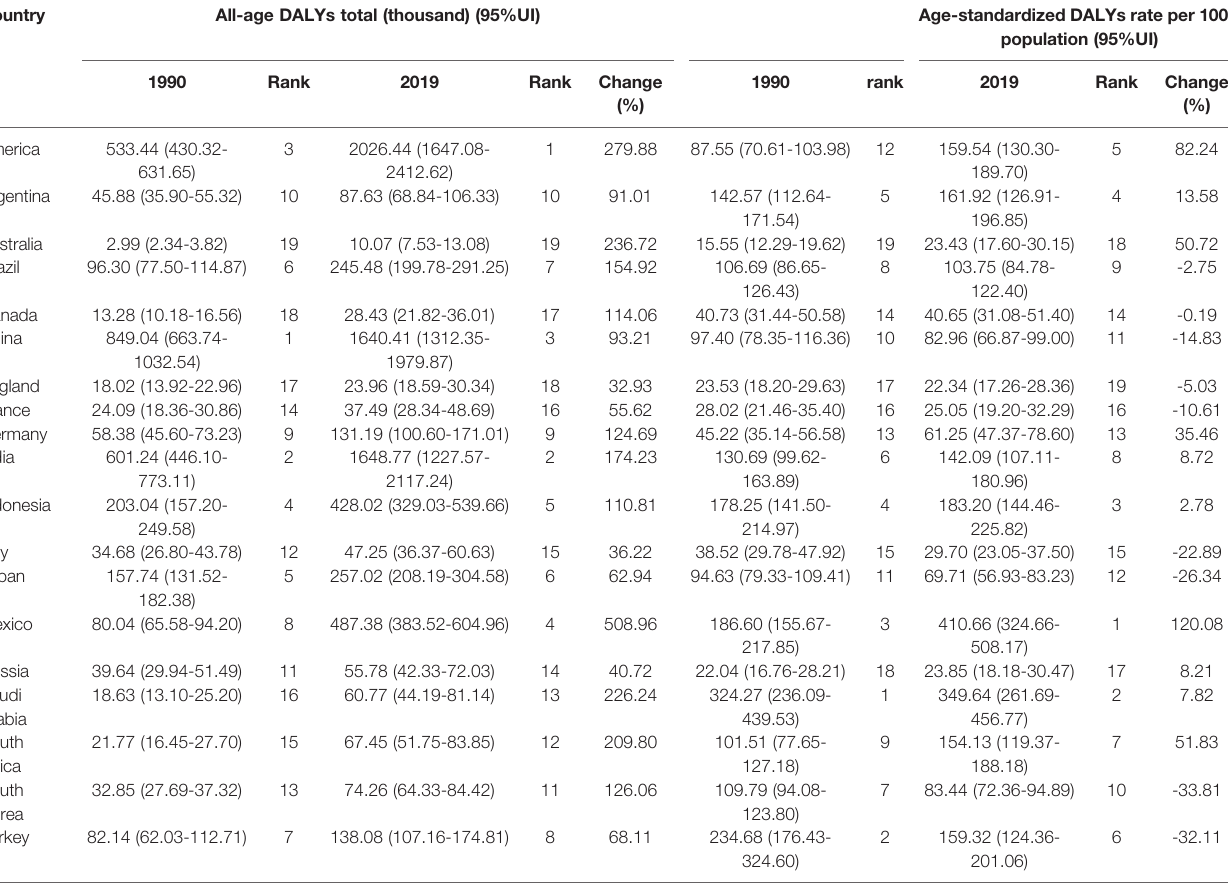
TABLE 2 | All-age DALYs and age-standardized DALYs rate (per 100,000 population) for T2DM-related CKD in 1990 and 2019 among the G20 countries (the 20th member is the European Union). Country